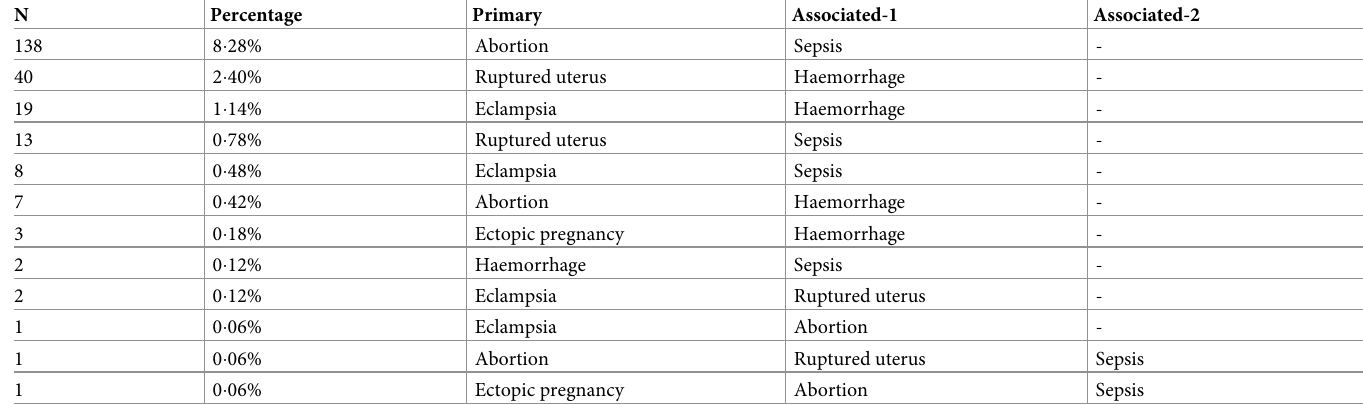
Table 3. Associated direct causes to the reported primary maternal cause of death (n = 1,666).